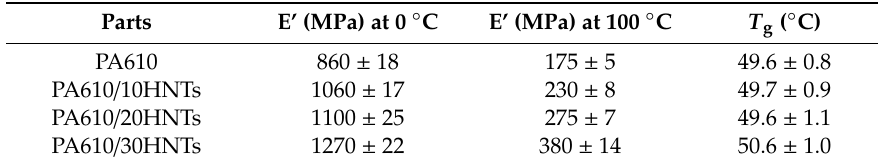
Table 5. Main thermomechanical parameters of the polyamide 610 (PA610) composites with di ff erent HNTs